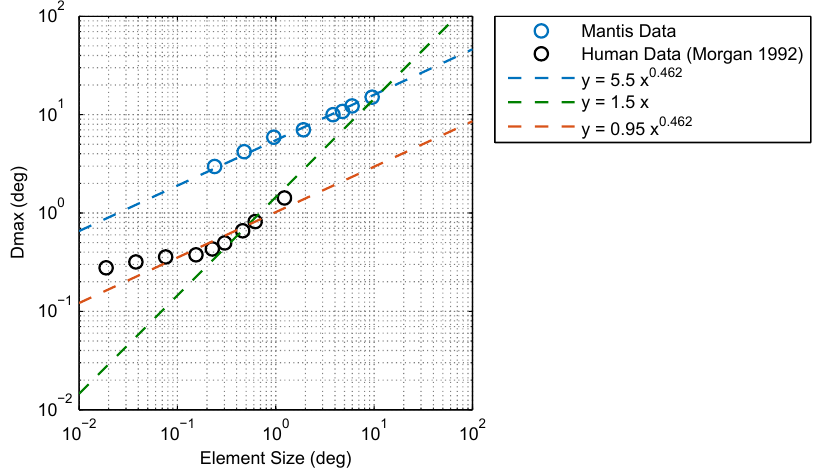
Figure 12. Comparison between Dmax in humans and mantids. Mantis Dmax increases with the element size, similar to humans, but does not appear to have a lower limit below which it remains constant (in humans, this limit is about 15 arcmin = 0.25 deg). The relationship between mantis Dmax and element size is well accounted for by a power law function with an exponent of 0.462 (blue line). Human data from [3] is plotted for comparison. Morgan interpreted the Dmax values he observed as scaling proportionately for element sizes larger than 0.25 deg (i.e., assumes a power law exponent of 1, green line) although his data appears to be accounted for equally well by a power law with an exponent of 0.462 (red line), similar to mantids. It is, therefore, unclear as to whether a true difference in power law exponents exists between humans and